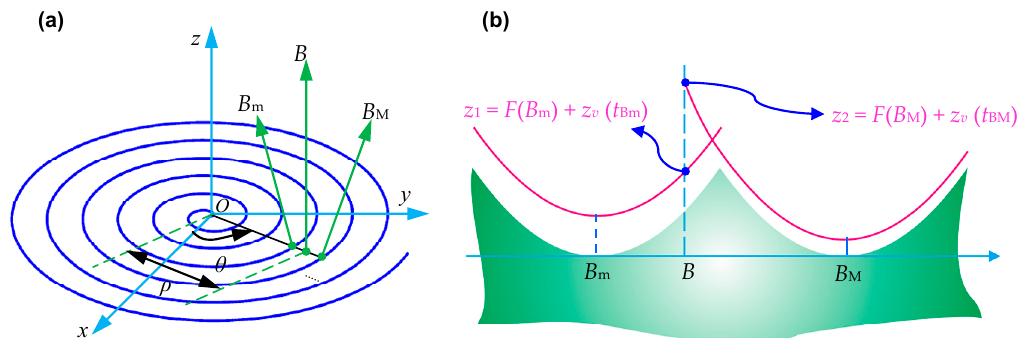
Figure 6. Illustration for the ‘trim principle’ employed in the calculation of surface topography in radial direction: ( a ) polar coordinate of the workpiece surface and position of B , B m and B M ; ( b ) sectional view of height coordinate of point B . Reproduced with permission from [28].